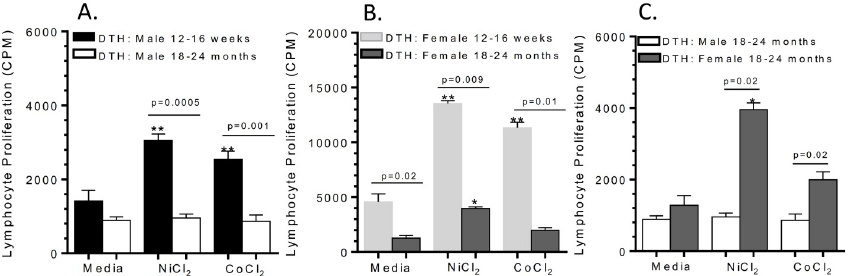
Fig 7. Age and sex effects lymphocyte metal-DTH responses. Post metal-DTH induction, lymphocytes were purified from mouse spleens and co-cultured with or without Ni or Co challenge. Comparison of lymphocyte proliferation to Ni and Co from metal-DTH younger and aged: (A) males, (B) females. And comparison of LTT responses among (C) aged male vs. female metal-DTH treated BL/6 mice. Cell proliferation was measured by 3 H-thymidine incorporation. Data represents two independent experiments with n = 4–5 mice/group in each experiment. Data are shown as the mean ± SEM. Statistical significance was determined by unpaired Mann-Whitney test and asterisk ( �� ) denote significant differences at p < 0.005 and ( � ) p < 0.05 compared to respective in vitro media challenged cell